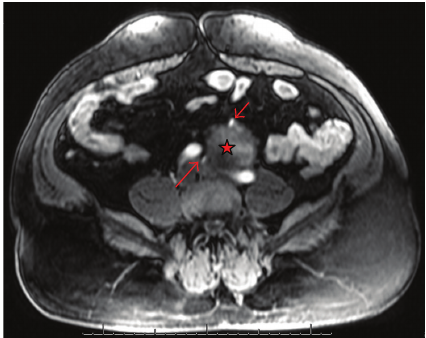
Figure 2: Arterial Phase T1-weighted MRI image (transverse view) showing anomalous arterial supply to ectopic left kidney and mass (star). Proximal left renal artery (short arrow) branching o ff distal aorta. Distal left renal artery (long arrow) branching o ff left common iliac artery.